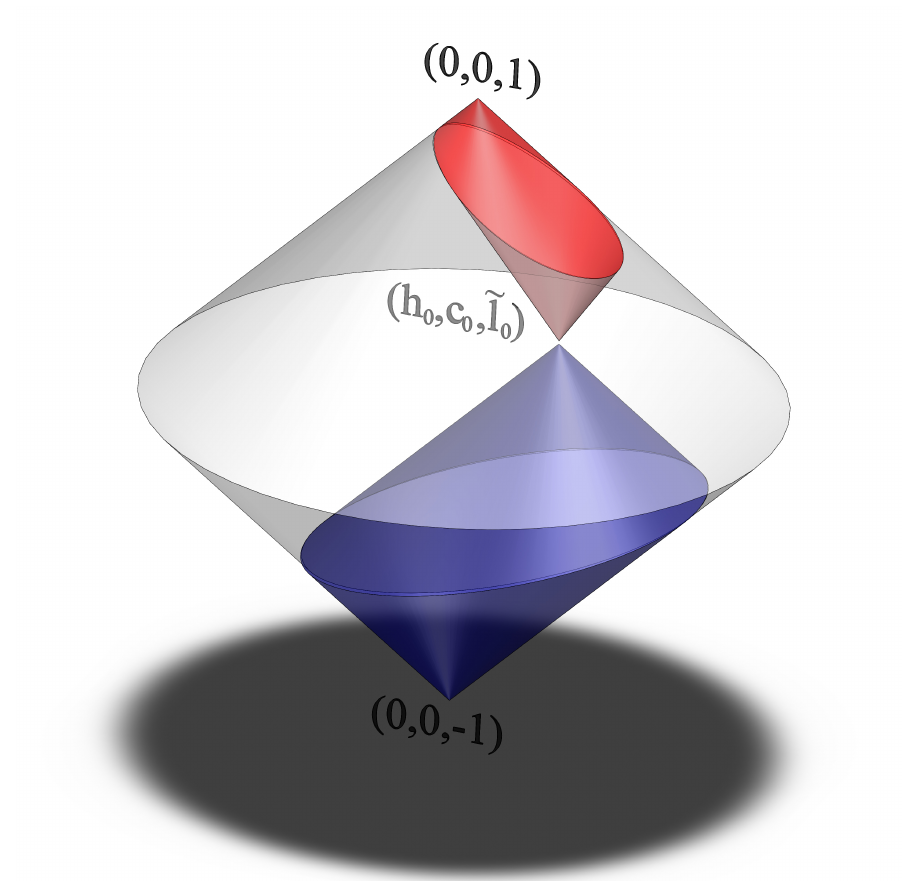
(cid:0) (cid:1) h 0 , c 0 , ˜ l 0 dominates all the colours in the